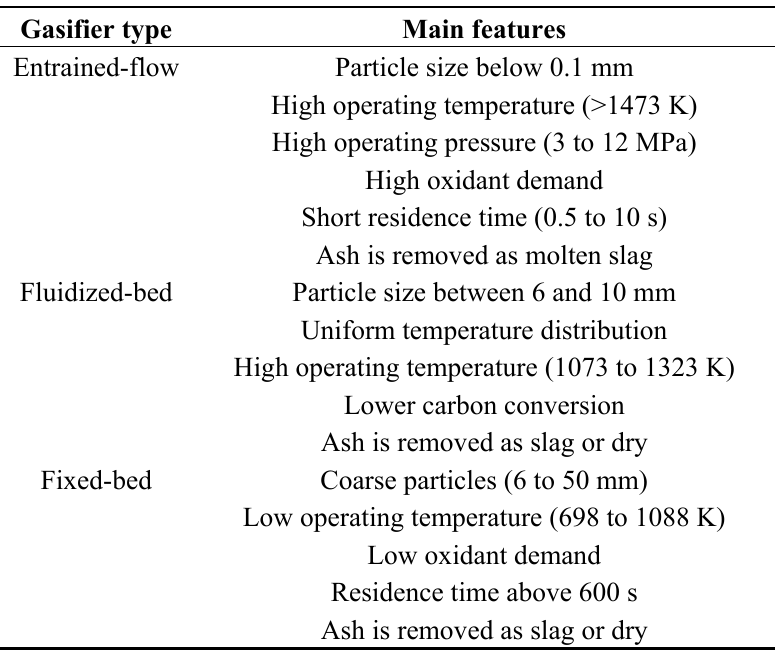
Table 2. Main features of industrial